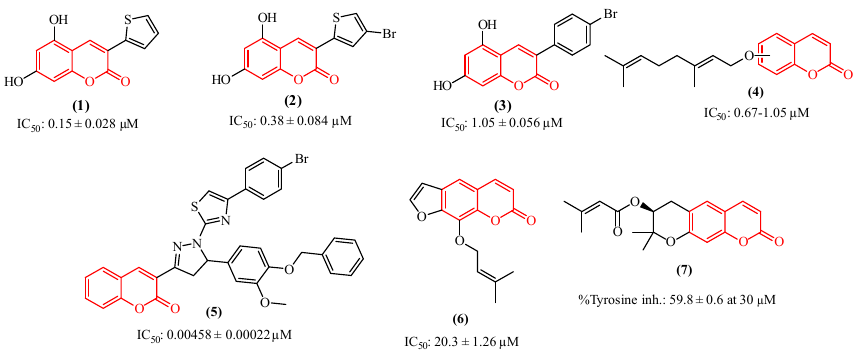
Figure 1. Coumarin ‐ based compounds with activity against the tyrosinase enzyme.